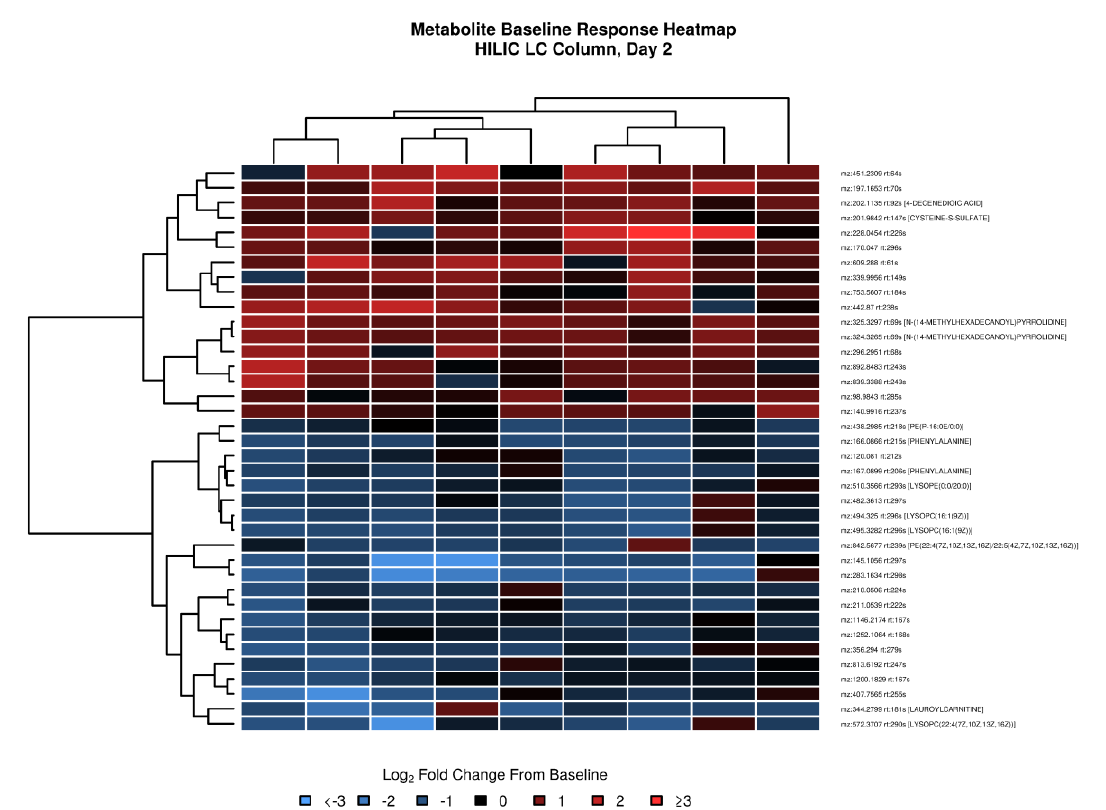
Figure 5. Heatmap of day 2 log 2 -fold changes from pre-vaccination for metabolites identified using the HILIC column. Rows represent DA metabolites, and columns represent samples. In red: increased signal compared to pre-vaccination; in blue: decreased signal compared to pre-vaccination. Dendrograms were obtained using complete linkage clustering of uncentered pairwise Pearson correlation distances between log 2 -fold changes. Metabolites are labeled by mass-to-charge ratio ( m / z ) and retention time (rt). Tentative chemical annotations are provided for metabolites with an annotation confidence score ≥ 2. For metabolites with multiple annotations, the first annotation is shown. “D-” or “L-”, “trans-” or “cis-” were removed from the annotations as the applied LC–MS method cannot distinguish these cases.